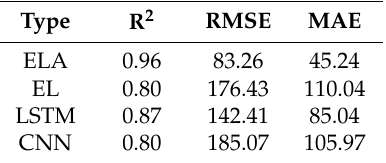
Table 2. Comparison of one-hour forecasting performance indices.